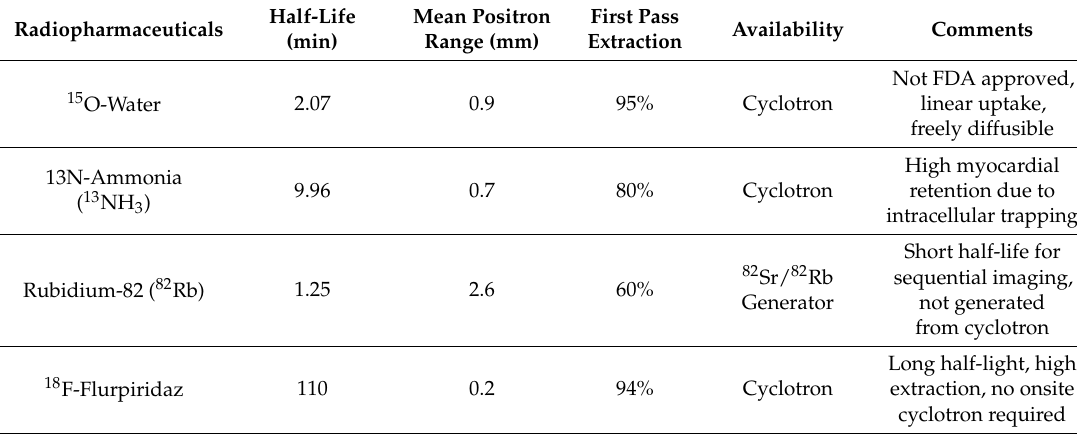
Table 1. Radiotracers for PET MPI.